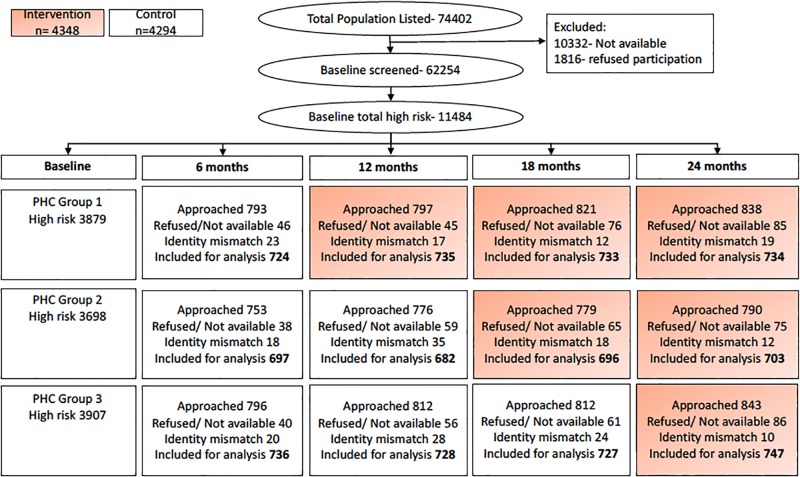
Study flow.PHC: Primary health centre.